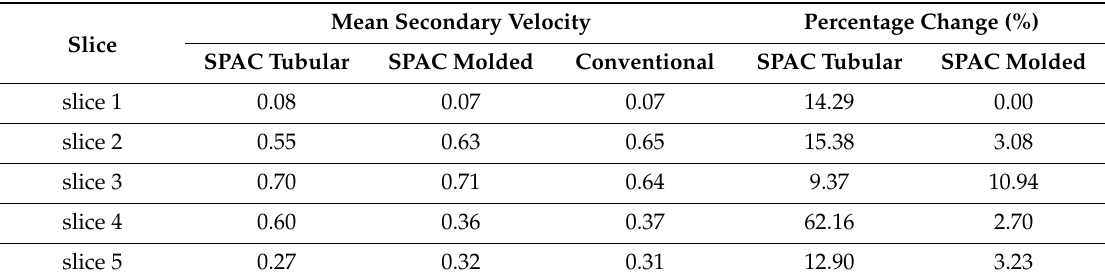
Table 7. The mean secondary velocity of all cases on five slices at t 4 .